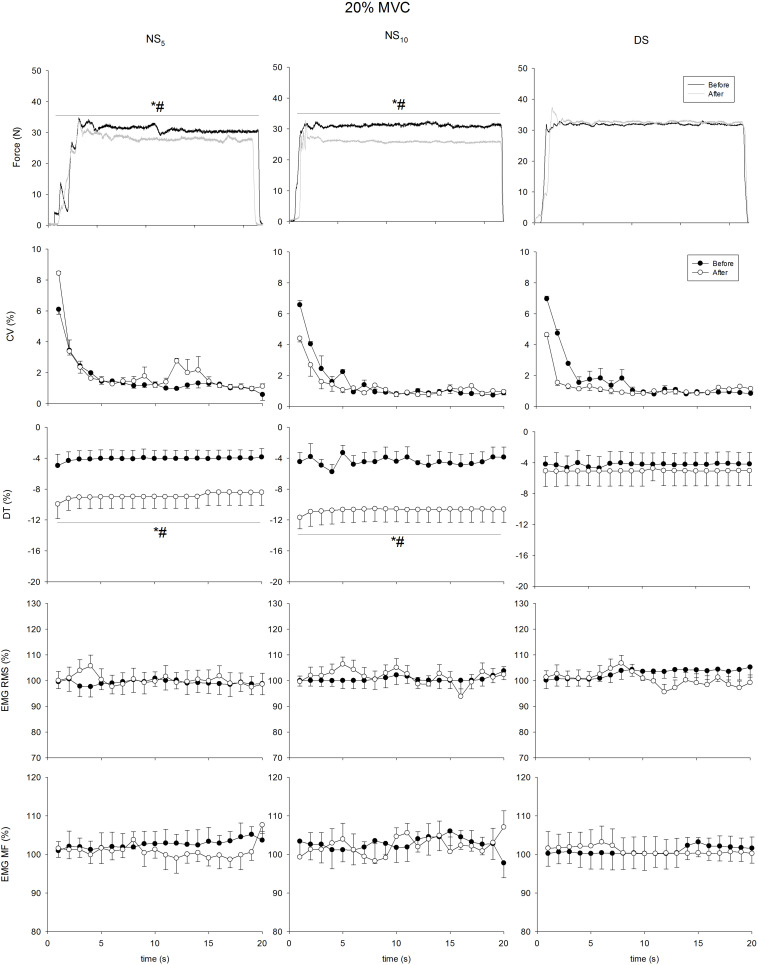
Coefficient of variation (CV), distance to target (DT), surface electromyogram root mean square (sEMG RMS), and mean frequency (sEMG MF) at 20% of maximum voluntary contraction (MVC) force maintained for 20 s at the beginning (pre, solid circle) and at the end (post, blank circle) of the shift cycle for the three groups. NS5, 5-day night shift; NS10, 10-day night shift; DS, day/swing shift. *p < 0.05 post vs. pre; #p < 0.05 NS5 or NS10 vs. DS.